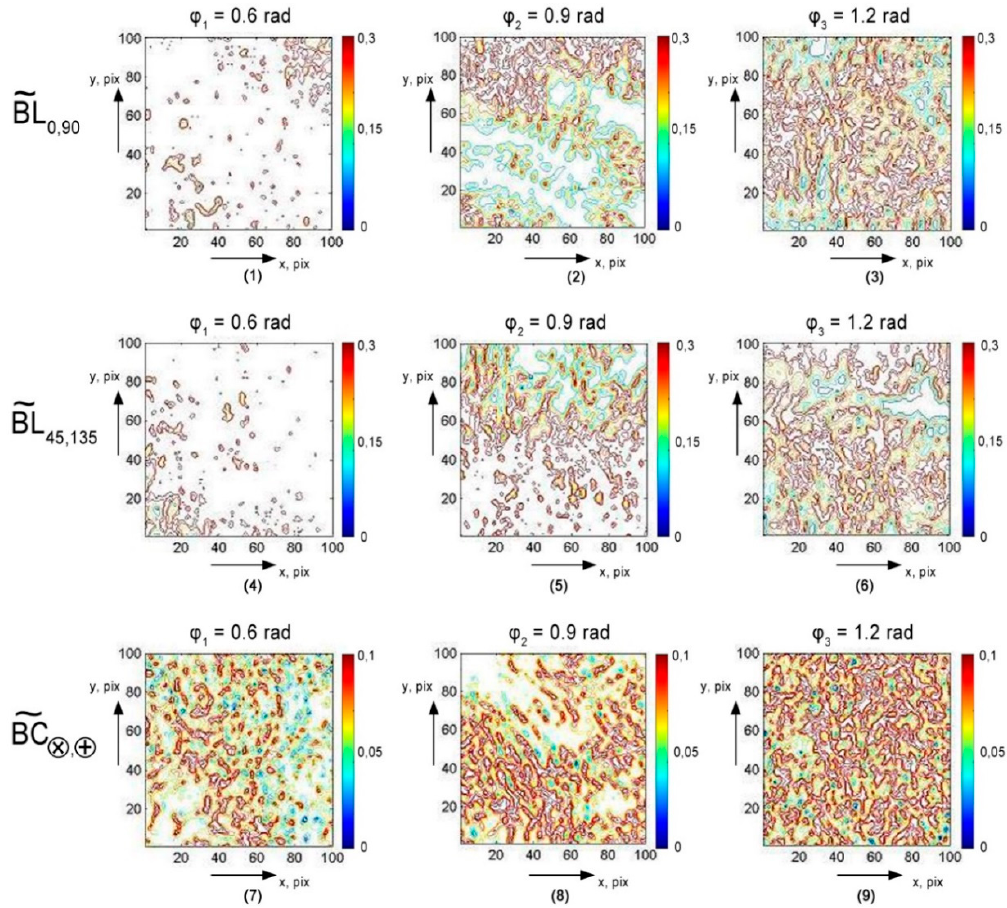
( ) (cid:16) (cid:17) μμϕ 10001000 × ;DT ϕ j ;1000 µ m × 1000 µ m of linear and circular birefringence mm of linear and circular birefringence j red =Δ=τ ).